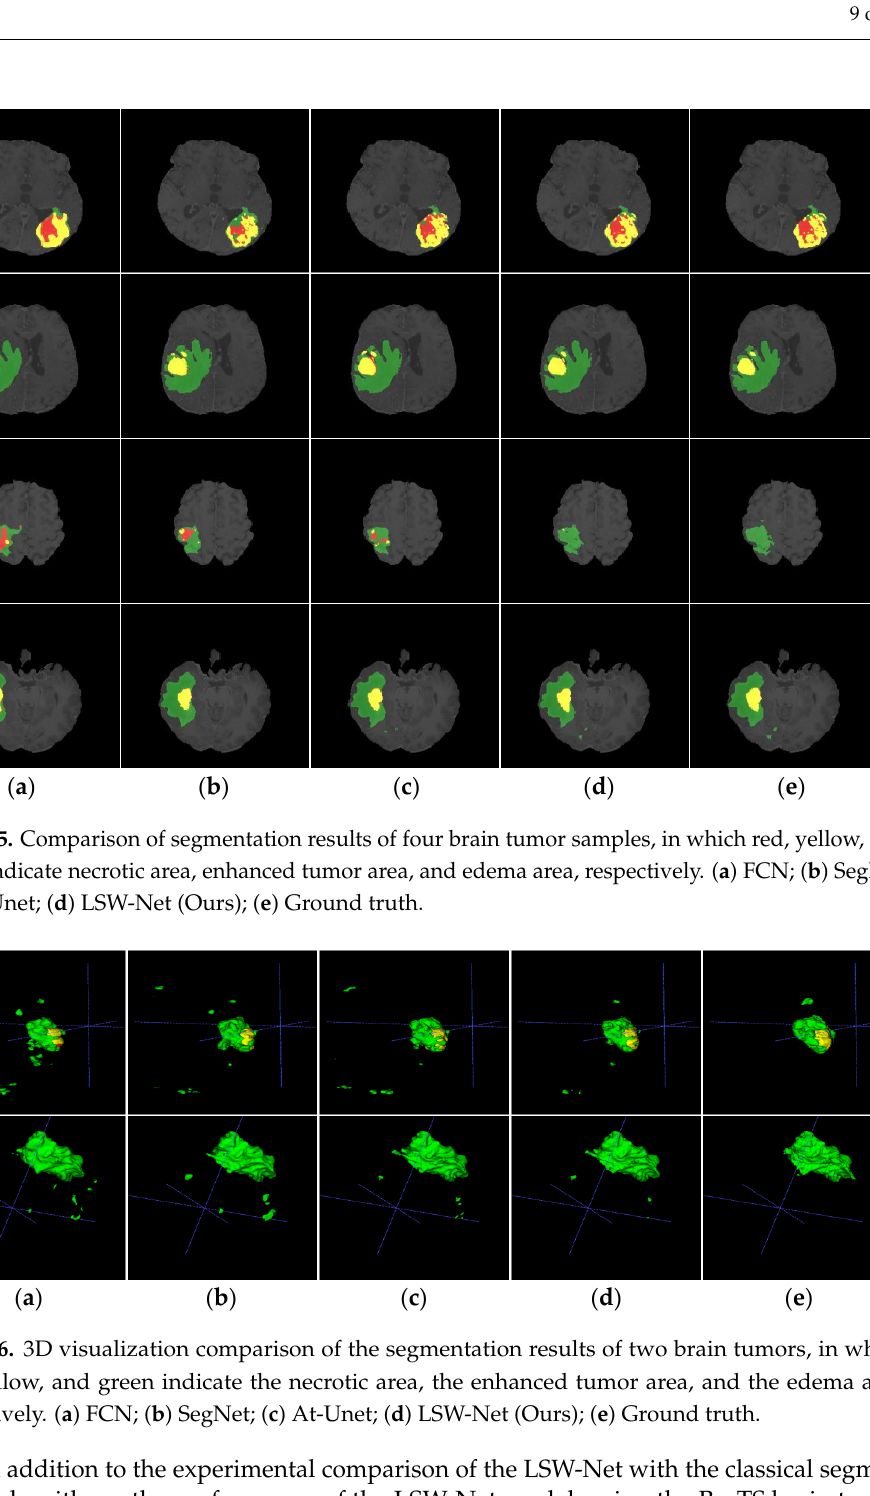
9 of 15 Table 2. Comparison of LSW-Net model with classical segmentation algorithms on BraTS2020. Method